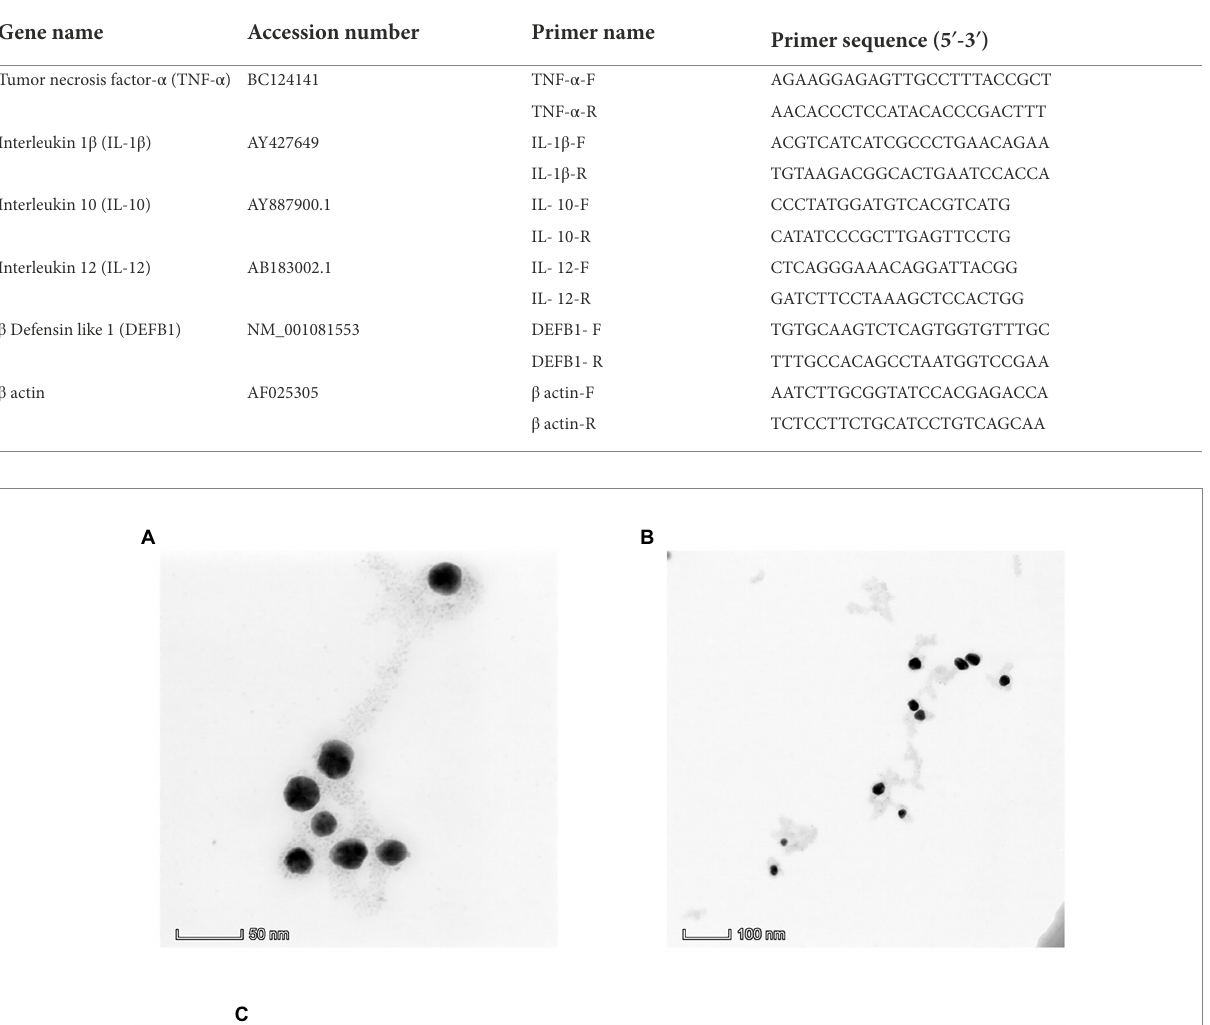
TABLE 1 Sequences of primers used for qPCR in this study.